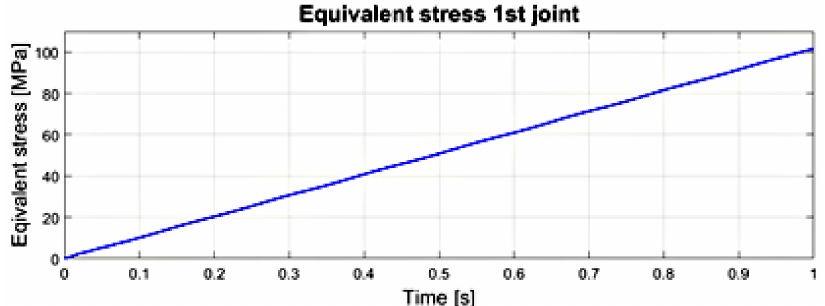
Figure 22. The course of stress reduced according to the von Mises hypothesis during the analysis of transient states—movement in the first joint of surgical